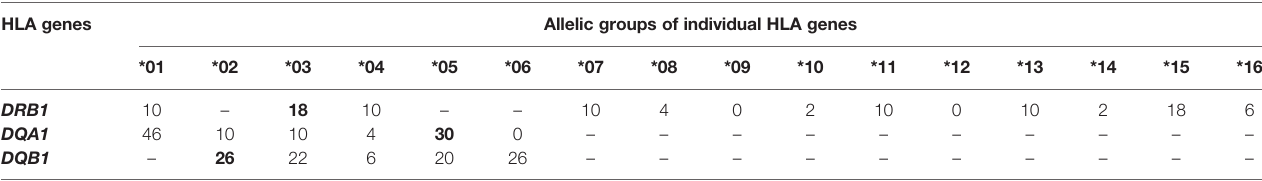
Data are given as %, frequencies of the risk variants of the particular genes are in bold. The asterix represent an established form of HLA genes nomenclature in accordance with the current HLA nomenclature (http://hla.alleles.org/nomenclature/nomenc_updates.html).